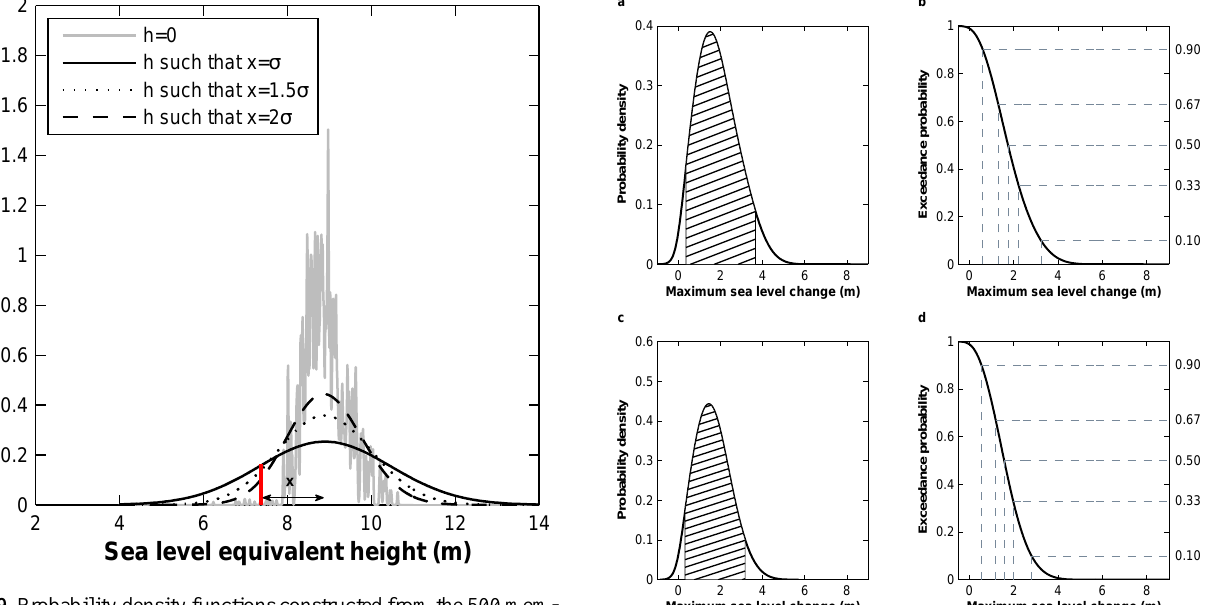
Fig. 9. Probability density functions constructed from the 500 mem- ber ensemble of modern-day GrIS sea level equivalent height. The red line denotes the observation from Bamber et al. (2001). The dis- tance x represents the difference between the mean of the ensemble and the observation. The grey line shows the probability density function with no smoothing. The black lines show the cases where the smoothing parameter, h , results in a probability density function where x = σ (solid), x = 1 . 5 σ (dotted) and x = 2 σ (dashed). ice sheet volume ensemble distribution. Figure 9 shows ker- nel widths that result in the measured ice volume lying 1, 1.5